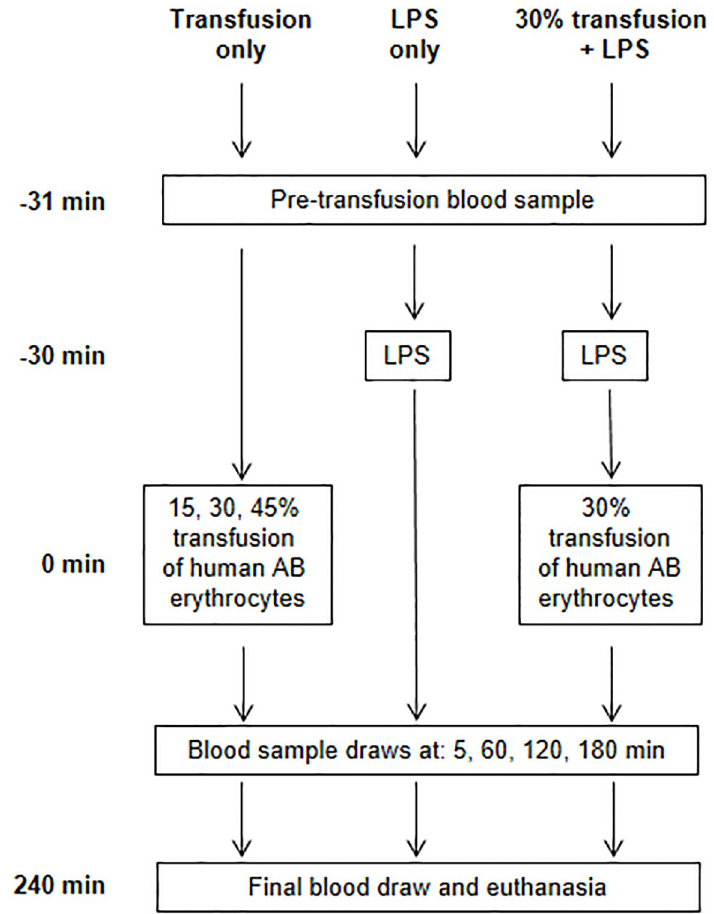
Fig 1. Experimental design and study